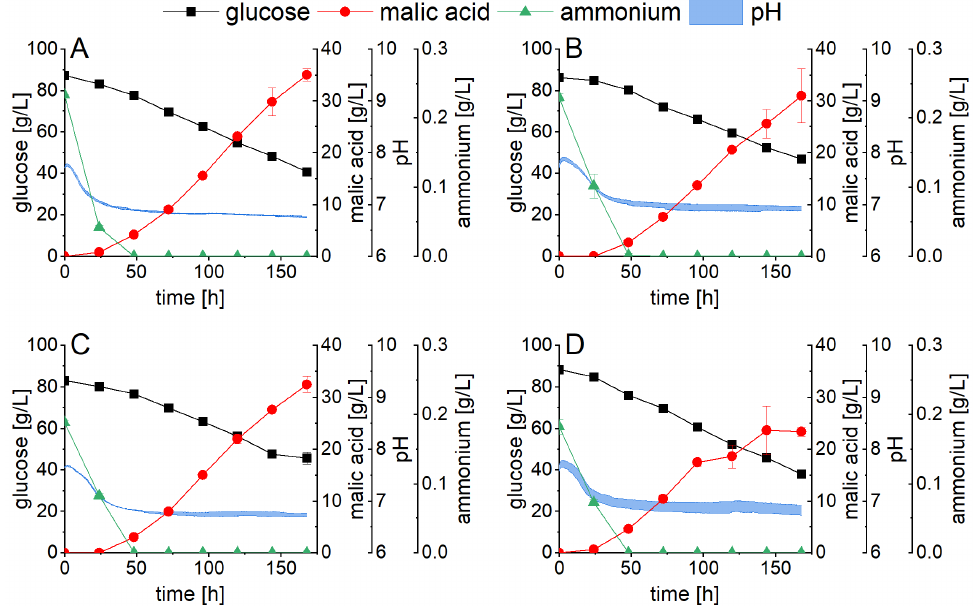
Figure 5. Malic acid production using glucose as carbon source in 2.5 L-bioreactors with free biomass ( A ) and A. oryzae immobilized in 1.5% alginate ( B ), 3% alginate ( C ), and 1.5% κ -carrageenan ( D ). Values are means of duplicates with standard